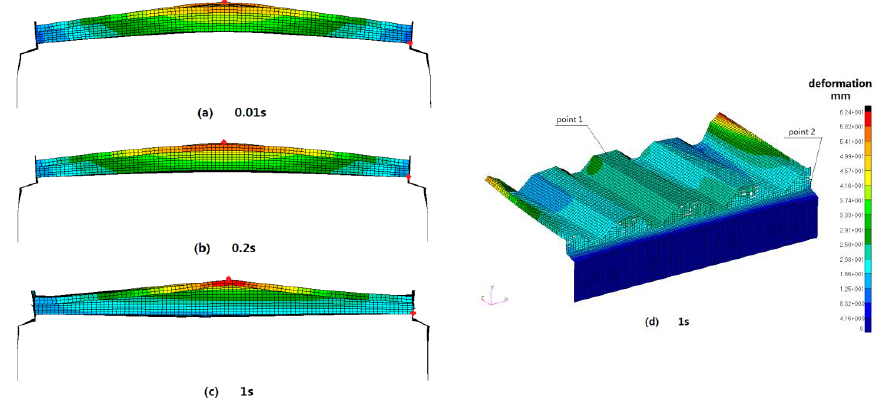
Figure 10. Deformation of the CBW. ( a ) the moment of 0.01 s, ( b ) the moment of 0.2 s, ( c ) the moment of 1 s, ( d ) the moment of 1 s in isometric view.